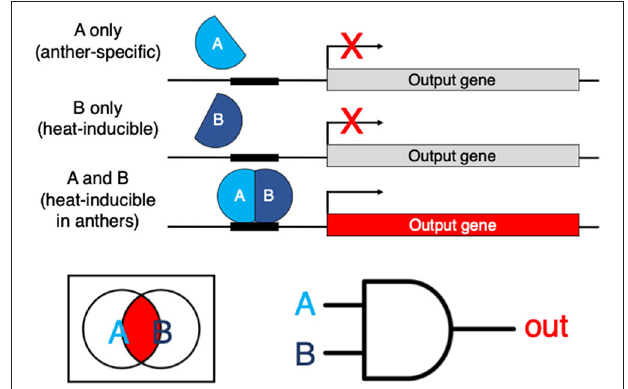
FIGURE 1 | An example of a hypothetical genetic Boolean logic AND gate. AB is a heterodimeric transcription factor. If subunit A is expressed in anthers and subunit B is inducible by heat, the full transcription factor is reconstituted only in heat-stressed anthers. The AND logic restricts the expression of the output gene of interest specifically to the tissues and conditions where/when both A and B